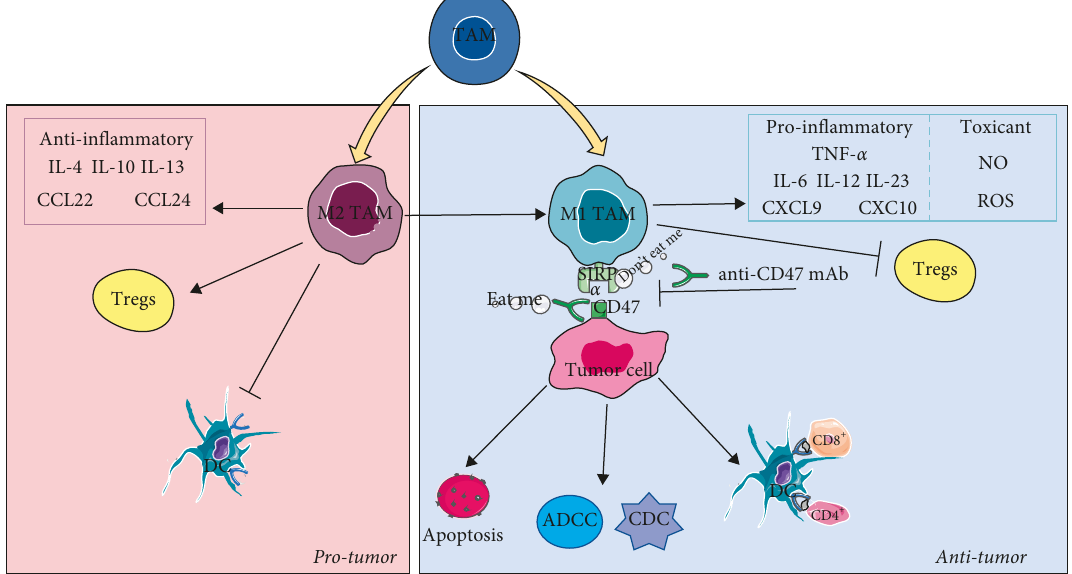
Figure 6: The effect of TAMs in tumor treatment. TAMs are divided into M1 TAMs and M2 TAMs. The M2 TAMs are protumor through secreting anti-inflammatory cytokines and chemokines, enhancing infiltration of Tregs in tumor site and inhibiting antigen presentation of DCs. The M1 TAMs are antitumor through enhancing polarization of M2 TAMs to M1 TAMs, secreting proinflammatory cytokines and chemokines as well as toxicant and blocking the CD47/SIRP α pathway. Abbreviations: TAMs, tumor-associated